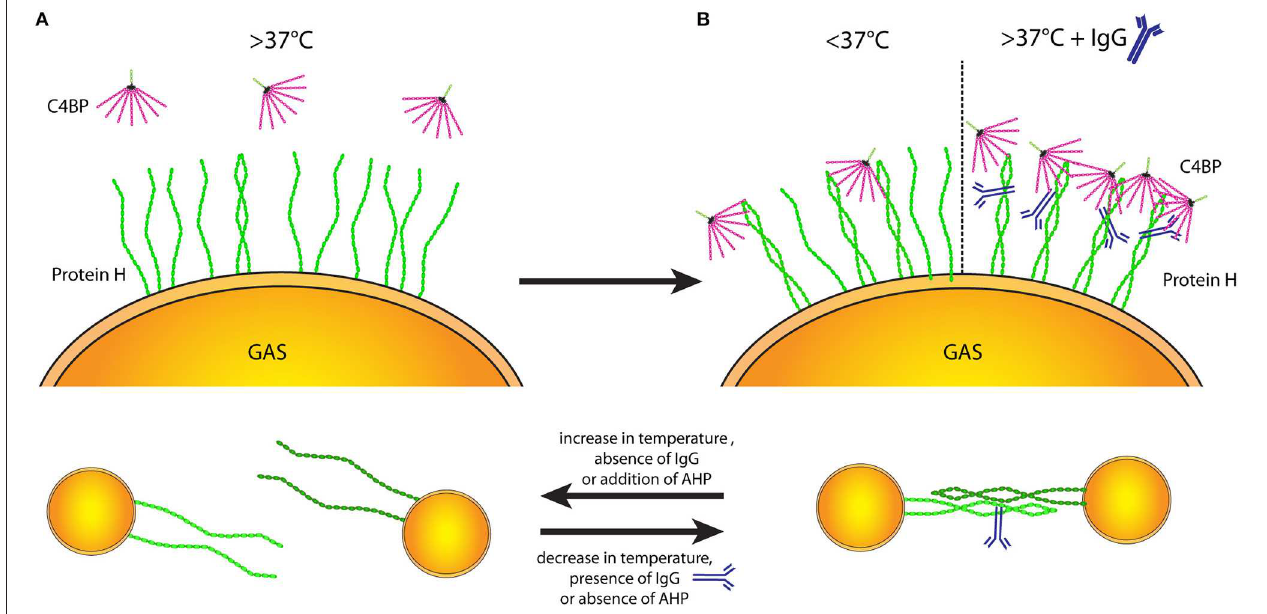
FIGURE 7 | Protein H structure influences ligand binding and interbacterial interaction. Temperature-dependent dimerization allows various interactions of Protein H. (A) At temperatures of 37 ◦ C and above the majority of Protein H is monomerized and cannot bind any ligands (incl. C4BP). (B) Upon decrease of temperature, increasing numbers of Protein H homodimers form and allow interaction with other molecules (left side). Beside low temperatures, IgG binding can stabilize Protein H homodimers even at high temperatures so that Protein H retains its binding capacity to different ligands (right side). (C) Protein H homodimers do not only bind to ligands, but also allow homo-tetramer formation to promote interbacterial interaction. Protein H monomers however cannot facilitate bacteria-bacteria interactions. Similar to ligand binding, lower temperature and presence of IgG at high temperatures stabilize Protein H dimers allowing for tetramer formation (right side). An increase of temperature as well as absence of IgG a high temperature causes Protein H monomerization and loss of function. AHP also causes loss of protein-Protein H interaction (tetrameric state reduced to dimeric state) and can at large molar excess also cause monomerization of Protein